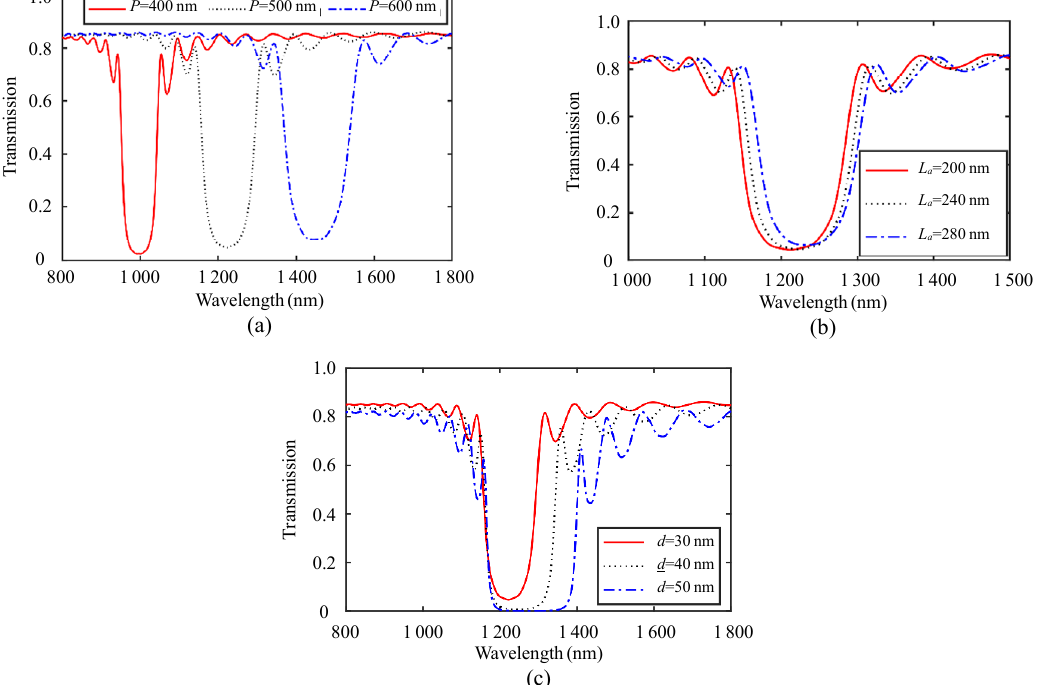
Fig. 5 Transmission spectra: (a) different grating periods of 400 nm, 500 nm, and 600 nm, respectively, (b) different lengths of metal gratings of 200 nm, 240 nm, and 280 nm, respectively, and (c) different widths of metal gratings of 30 nm, 40 nm, and 50 nm,